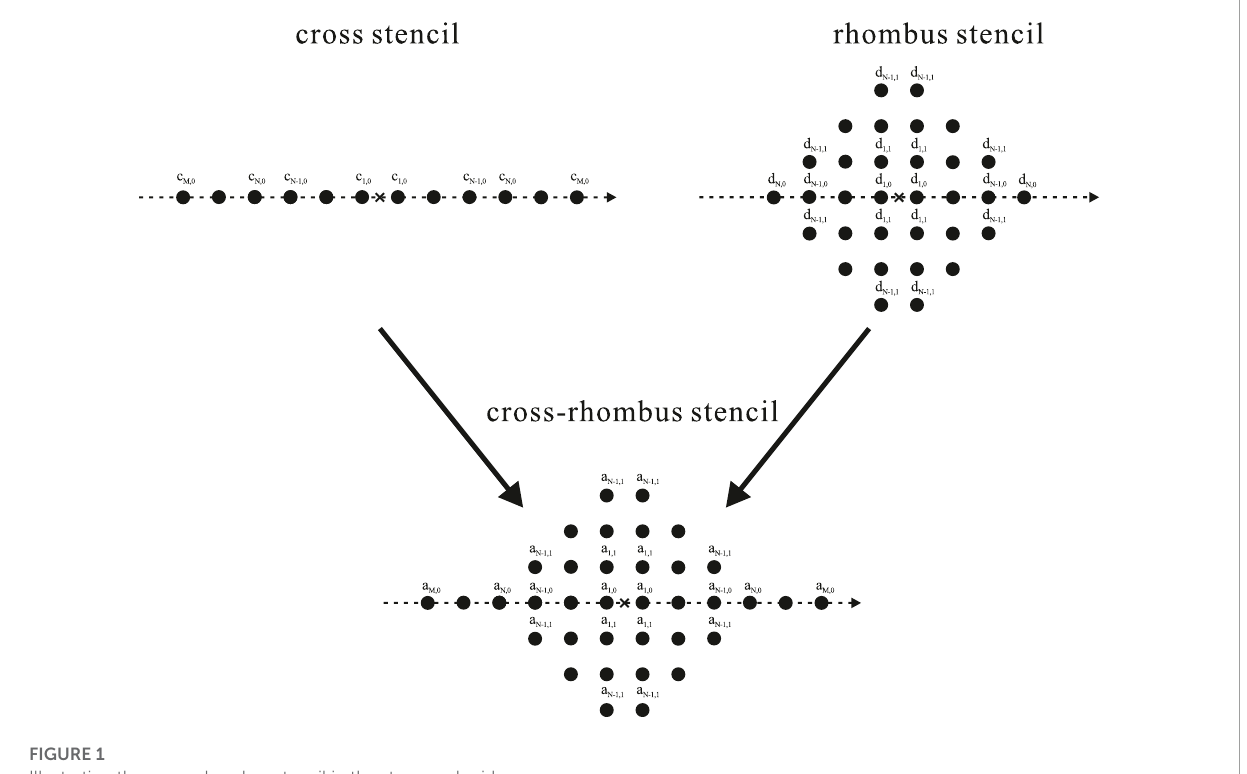
FIGURE 1 Illustrating the cross-rhombus stencil in the staggered